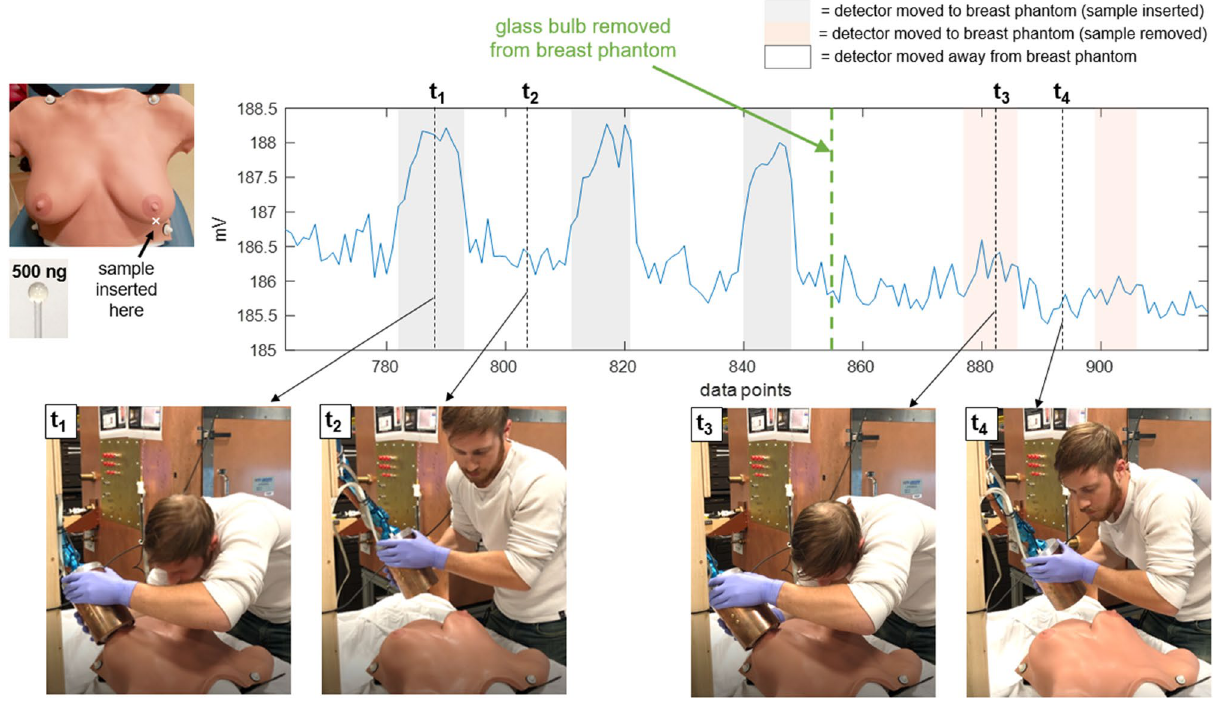
Figure 8. Breast phantom detection results, detector moved, left breast lower outer quadrant. Detection of a 500 ng Fe SPIO sample embedded in the anthropomorphic breast phantom in the lower outer quadrant of the left breast. The detector is held by hand and moved around during data acquisition to and away from the breast at the sample’s location. Four time points (t 1 –t 4 ) are selected to show still frames from a video of the experiment. (See S2 for video.) The SPIO sample (in glass bulb) is removed from the breast phantom at data point 855 (thick green dashed line). The acquisition scheme, receive chain setup, and data analysis are the same as described in the caption of Fig.